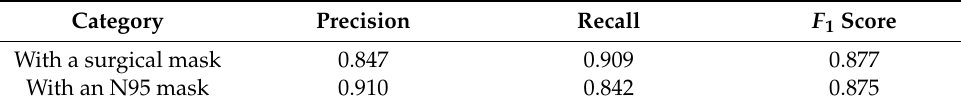
Table 2. Detection results of whether or not to wear mask.